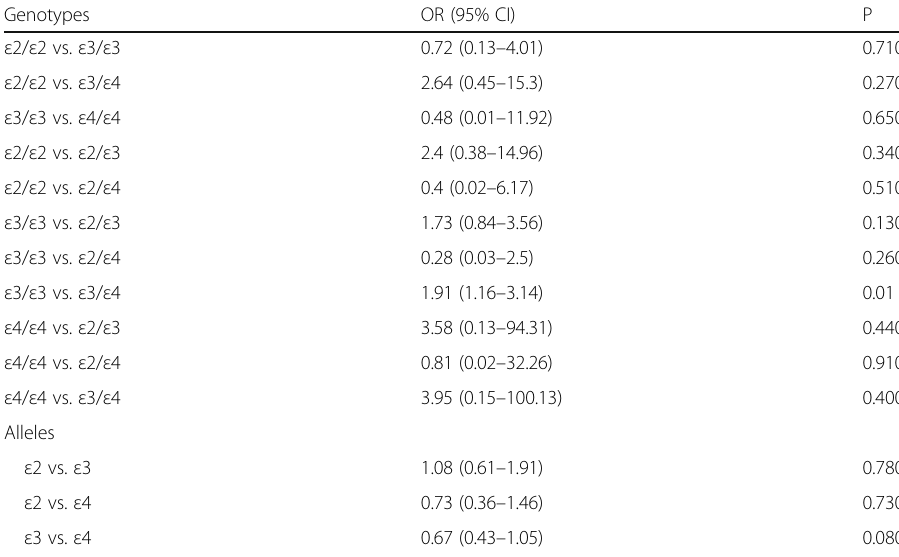
Table 3 Distribution of APOE genotypes and alleles in patients with aneurysmal SAH and